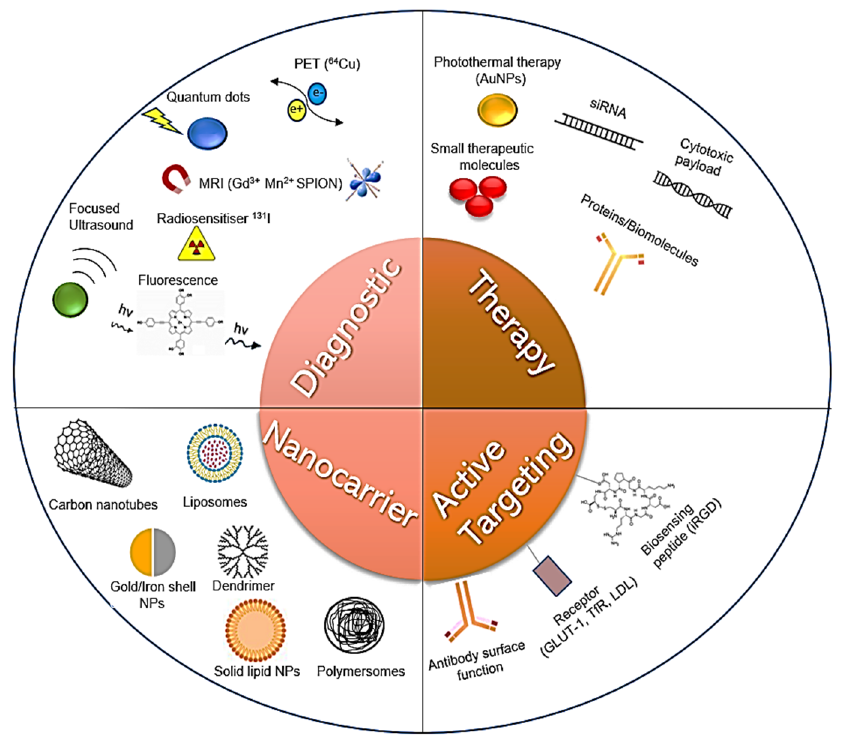
Figure 1. NTP platform design possibilities for targeted multifunctional imaging and treatment of CNS related disorders .